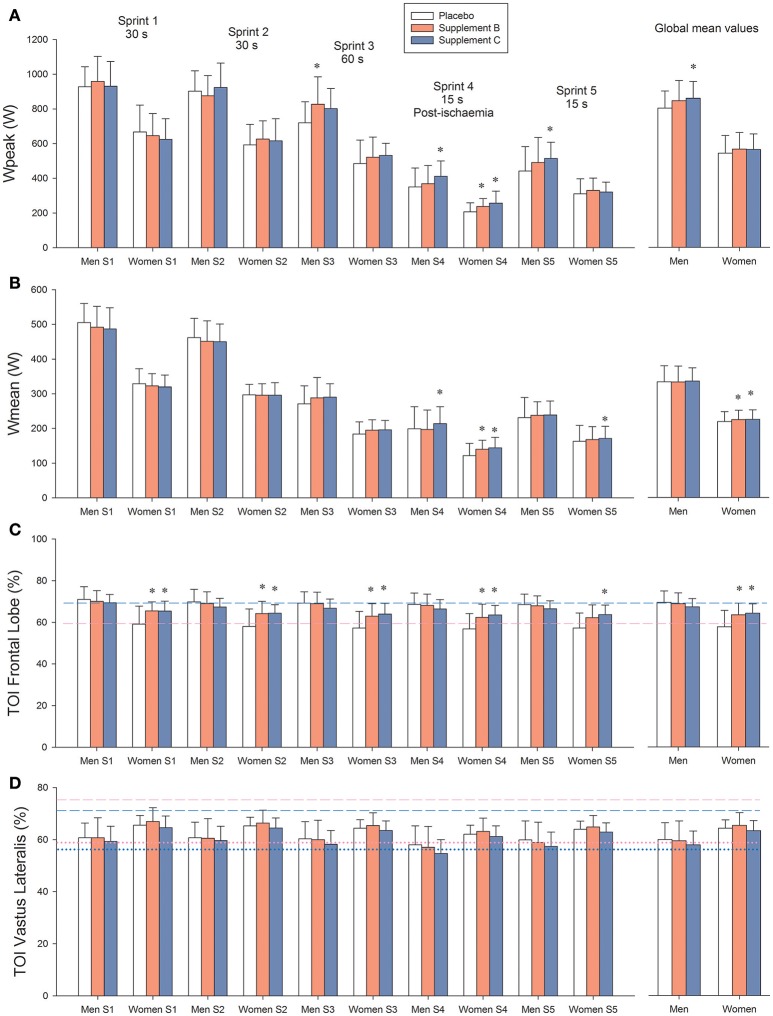
(A) Peak power output (Wpeak). (B) Mean power output (Wmean). (C) Brain oxygenation (Frontal lobe tissue oxygenation index: TOI). (D)
Vastus Lateralis oxygenation index. Treatment A: placebo (500 mg of maltodextrin per day); treatment B consisted of 140 mg of mango leaves extract and 50 mg of luteolin per day; and treatment C contained 140 mg of mango leaves extract, 600 mg of quercetin, and 350 mg of tiger nut extract per day. Dashed lines in (C,D) represent the values recorded at rest. Dotted lines in (D) represent the values observed during the last 5 s of the occlusions after sprint 3, i.e., is the TOI value corresponding to “zero oxygenation.” Blue color: men, pink color: females. *P < 0.05 compared with placebo.